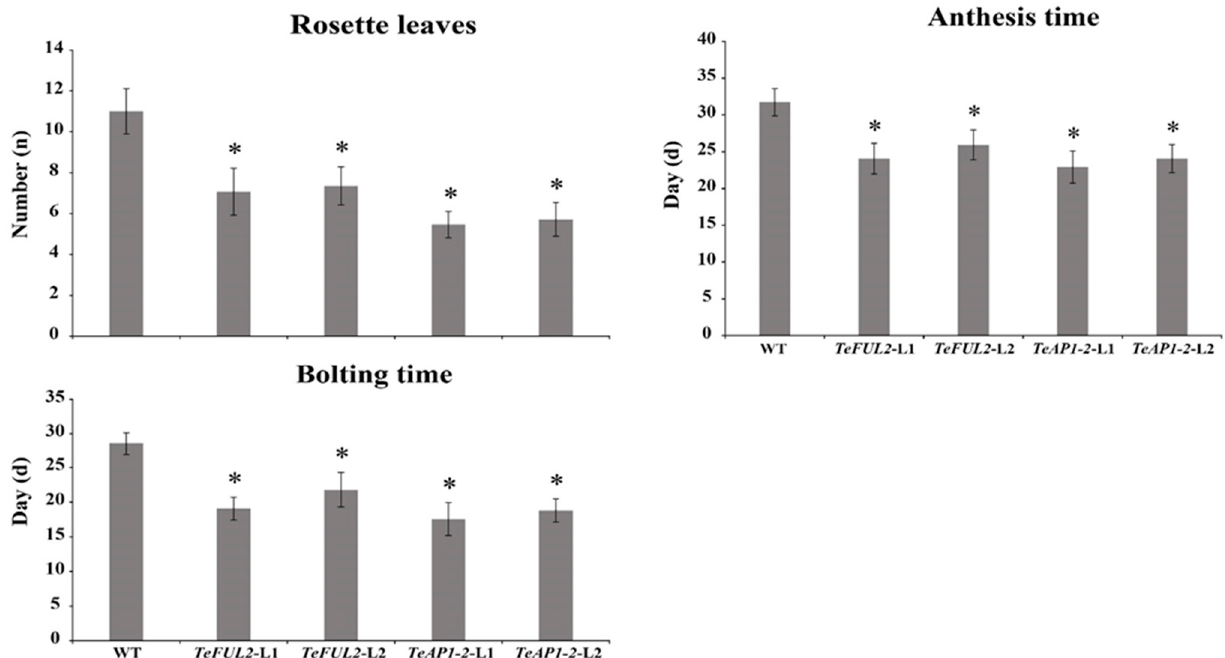
Figure 5. Statistics for main morphological traits of the control and transgenic plants. * Significant difference at p < 0.05.